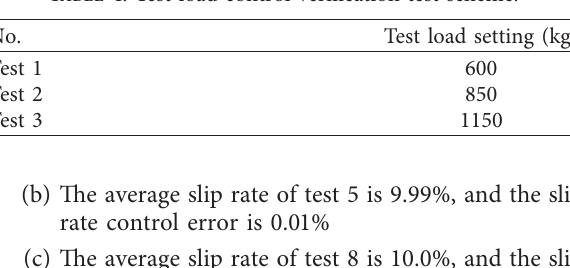
Table 4: Test load control verification test